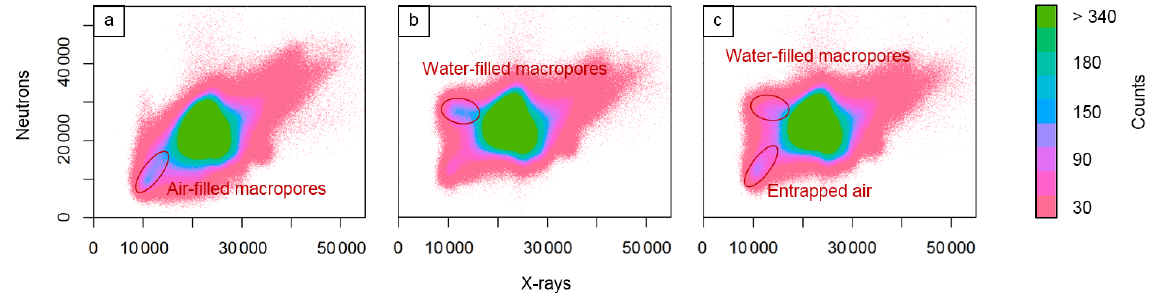
Figure 10. Bivariate histograms of cropped part of the X-ray and corresponding neutron tomograms, representing a soil sample with large macropores during various stages of recurrent ponding infiltration experiment. Histograms show (a) empty macropore before the infiltration was started, (b) filling of the macropores during the first infiltration, and (c) partial filling of the macropores during the second infiltration.